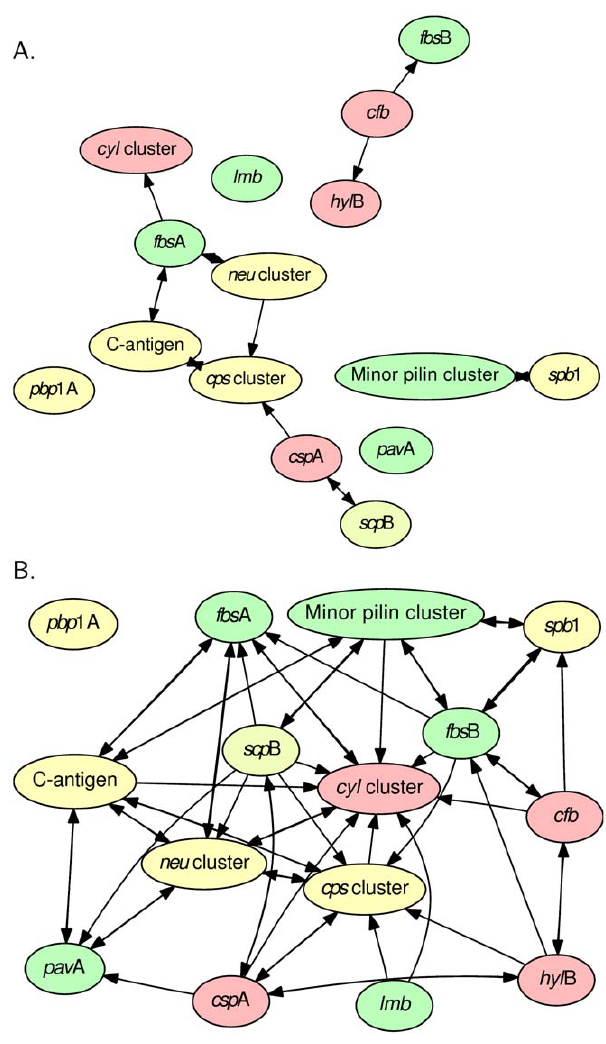
Figure 4. Inter-discovery between virulence gene categories. These figures provide two cross-sectional views of Figure 3 at the positions of top-1% (A) and -5% (B) respectively. The arrowheads indicates which other categories of virulence genes were discoverable by the category at the tail of arrow.